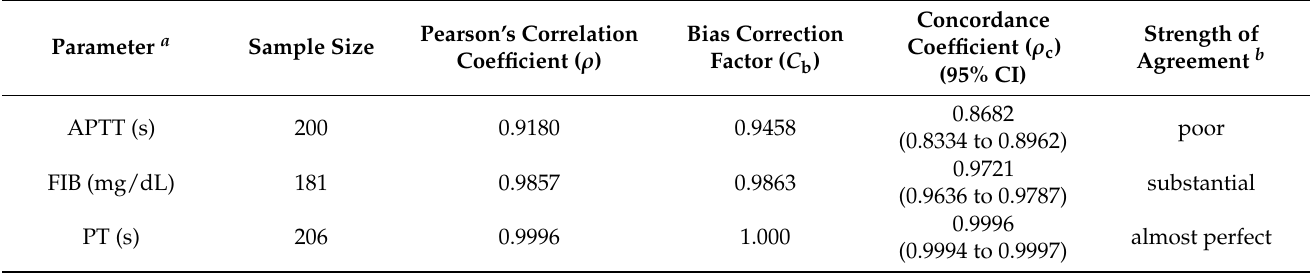
Table 2. Comparison among methods for activated partial thromboplastin time, fibrinogen, and prothrombin time.